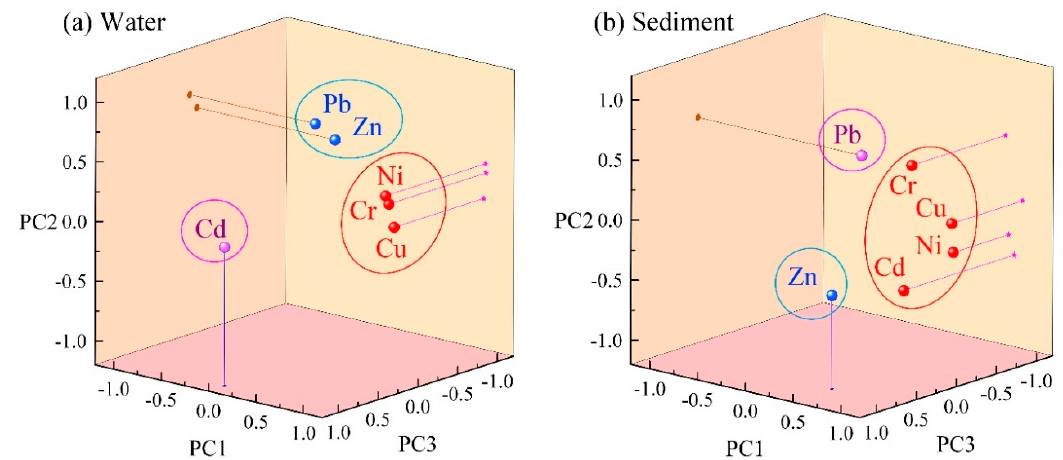
Figure 4. Load diagram of water ( a ) and sediment ( b ) principal component factor.